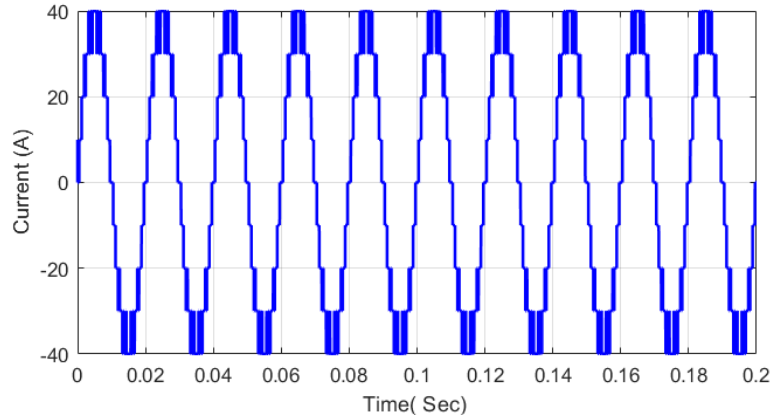
Energies 2022 , 15 , x FOR PEER REVIEW